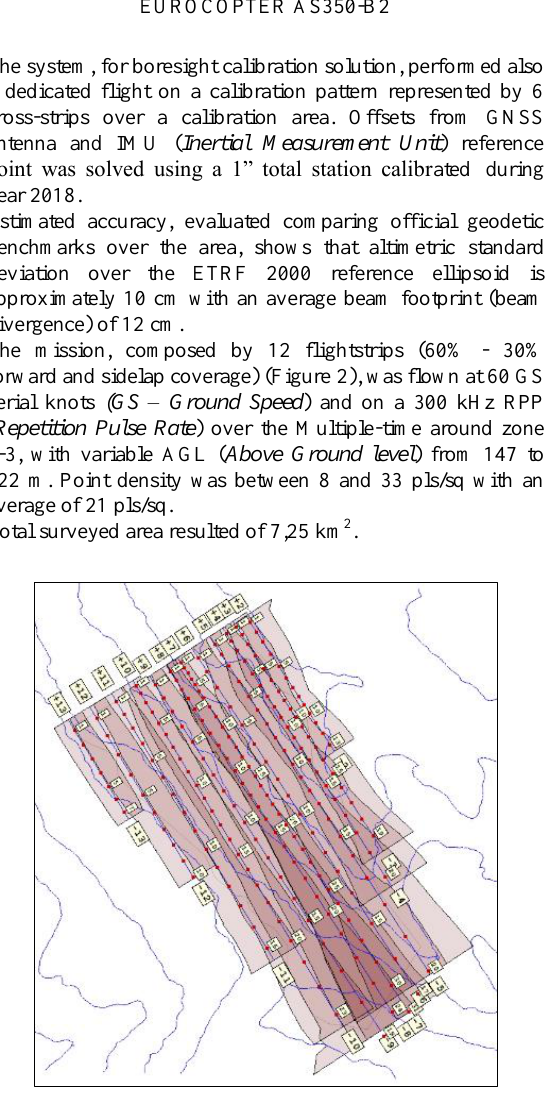
Figure 1. CNR IRPI aerial LiDAR mounted on EUROCOPTER AS350-B2